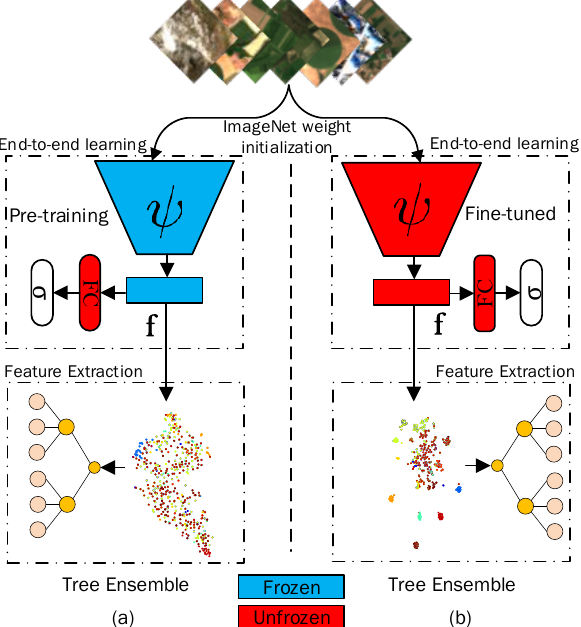
Figure 4. Two distinctive learning strategies for the MLC task. In the first learning setting, marked as ( a ), we rely on the ImageNet pre-training, where all the model layers are frozen, except the last fully connected layer, which is trained for the new target domain. In the second learning setting, marked as ( b ), the entire network architecture is fine-tuned along with the newly added fully connected layer. Moreover, we use both approaches either as feature extractors (in “offline” mode) jointly with tree ensemble methods, or as end-to-end learning machines to directly perform the MLC task. Note that the parts of the model highlighted with blue indicate that there is no update of the parameters in the model during the training process; on the other hand, with red, we highlight the opposite task, which means the parameters of the model are unfrozen and updated during